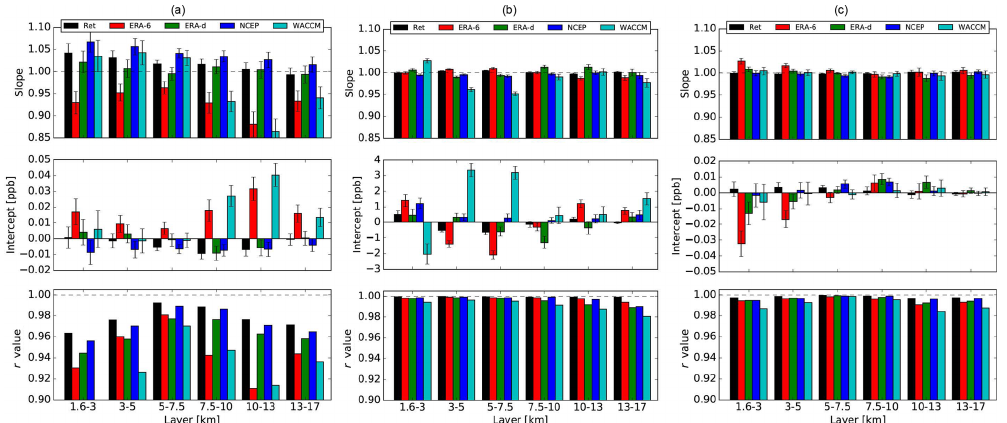
Figure 11. Results of the ODR analysis in which the mixing ratios using different WV sources at different layers are compared with the “truth” retrieved values using the NOAA FPH WV for HCN (a) , CO (b) , and C 2 H 6 (c) . Error bars represent the standard errors of the estimated parameters.